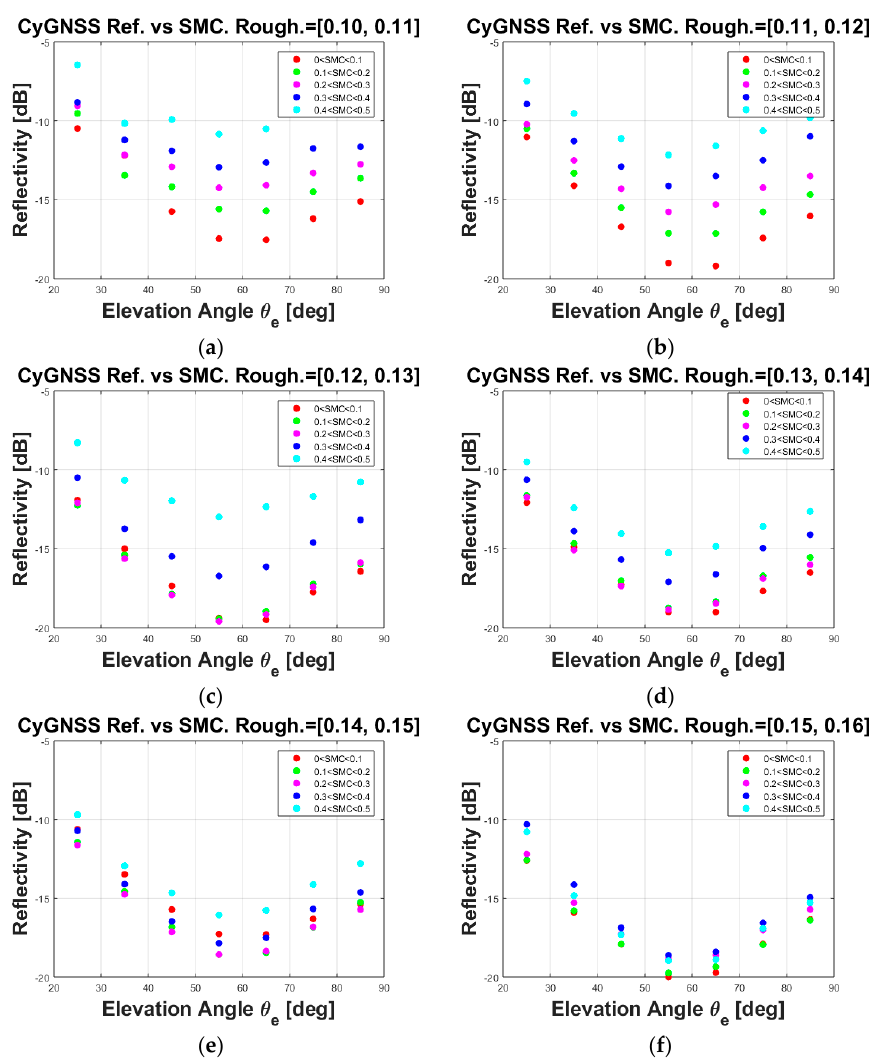
Figure 4. ( a ) Effective surface roughness parameter h over the Earth. ( b ) One-month (from 20 September to 20 October 2017) averaged SMAP-radiometer derived Soil Moisture Content (SMC).